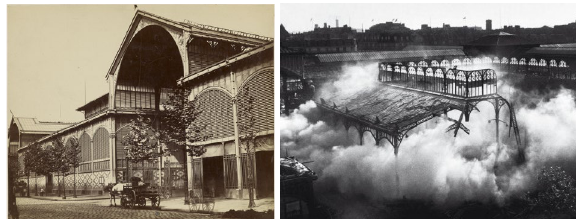
Figure 5. Les Halles of Baltard before and during demolitions in